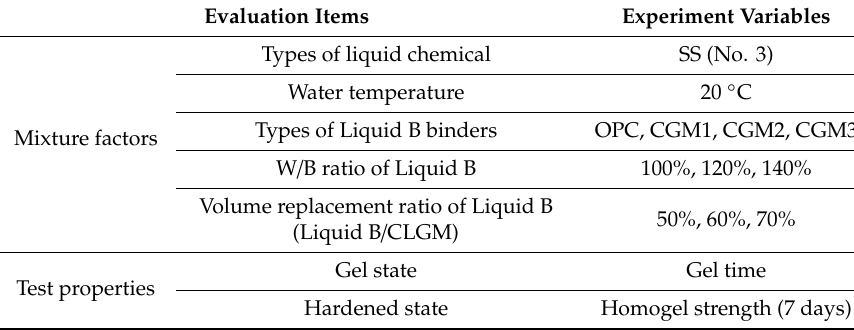
Table 4. Experiment plan. Note: CLGM, chemical liquid grouting